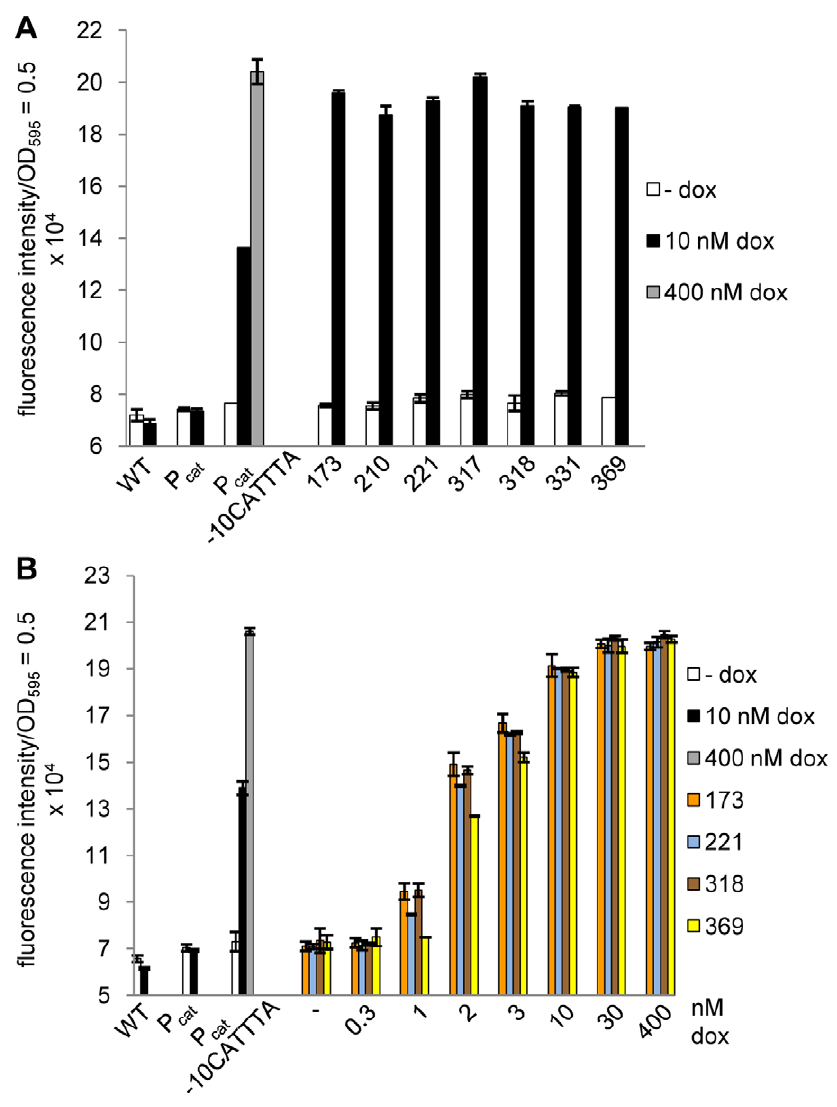
Figure 4. Identification of promoter mutants with increased TetR inducibility. (A) GFP fluorescence measurement of the seven promoter mutants with the highest reporter activity. (B) Dose-response curve of four promoter variants possessing different -10 elements to analyze the sensitivity of TetR induction at increasing dox concentrations. For both data sets, controls and cultivation were the same as in Fig. 3C. Bars illustrate the fluorescence intensity which was normalized to a 1 ml culture with OD 595 =0.5. The data are a representative set from at least three independent measurements and display the mean 6 standard deviation.